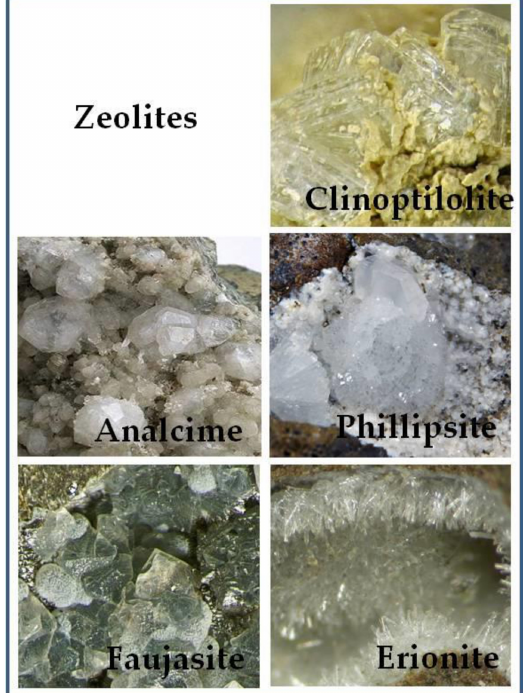
Figure 2. Some minerals with zeolite structure. Clinoptilolite photo by Christian Rewitzer Collection (CC BY-SA 3.0); Analcime photo by Carles Milan (CC BY 3.0); Phillipsite photo by Martin Zinn (CC-BY-SA-3.0); Faujasite photo by Modris Baum (Public Domain); Erionite photo by Leon Hupperichs (CC BY-SA